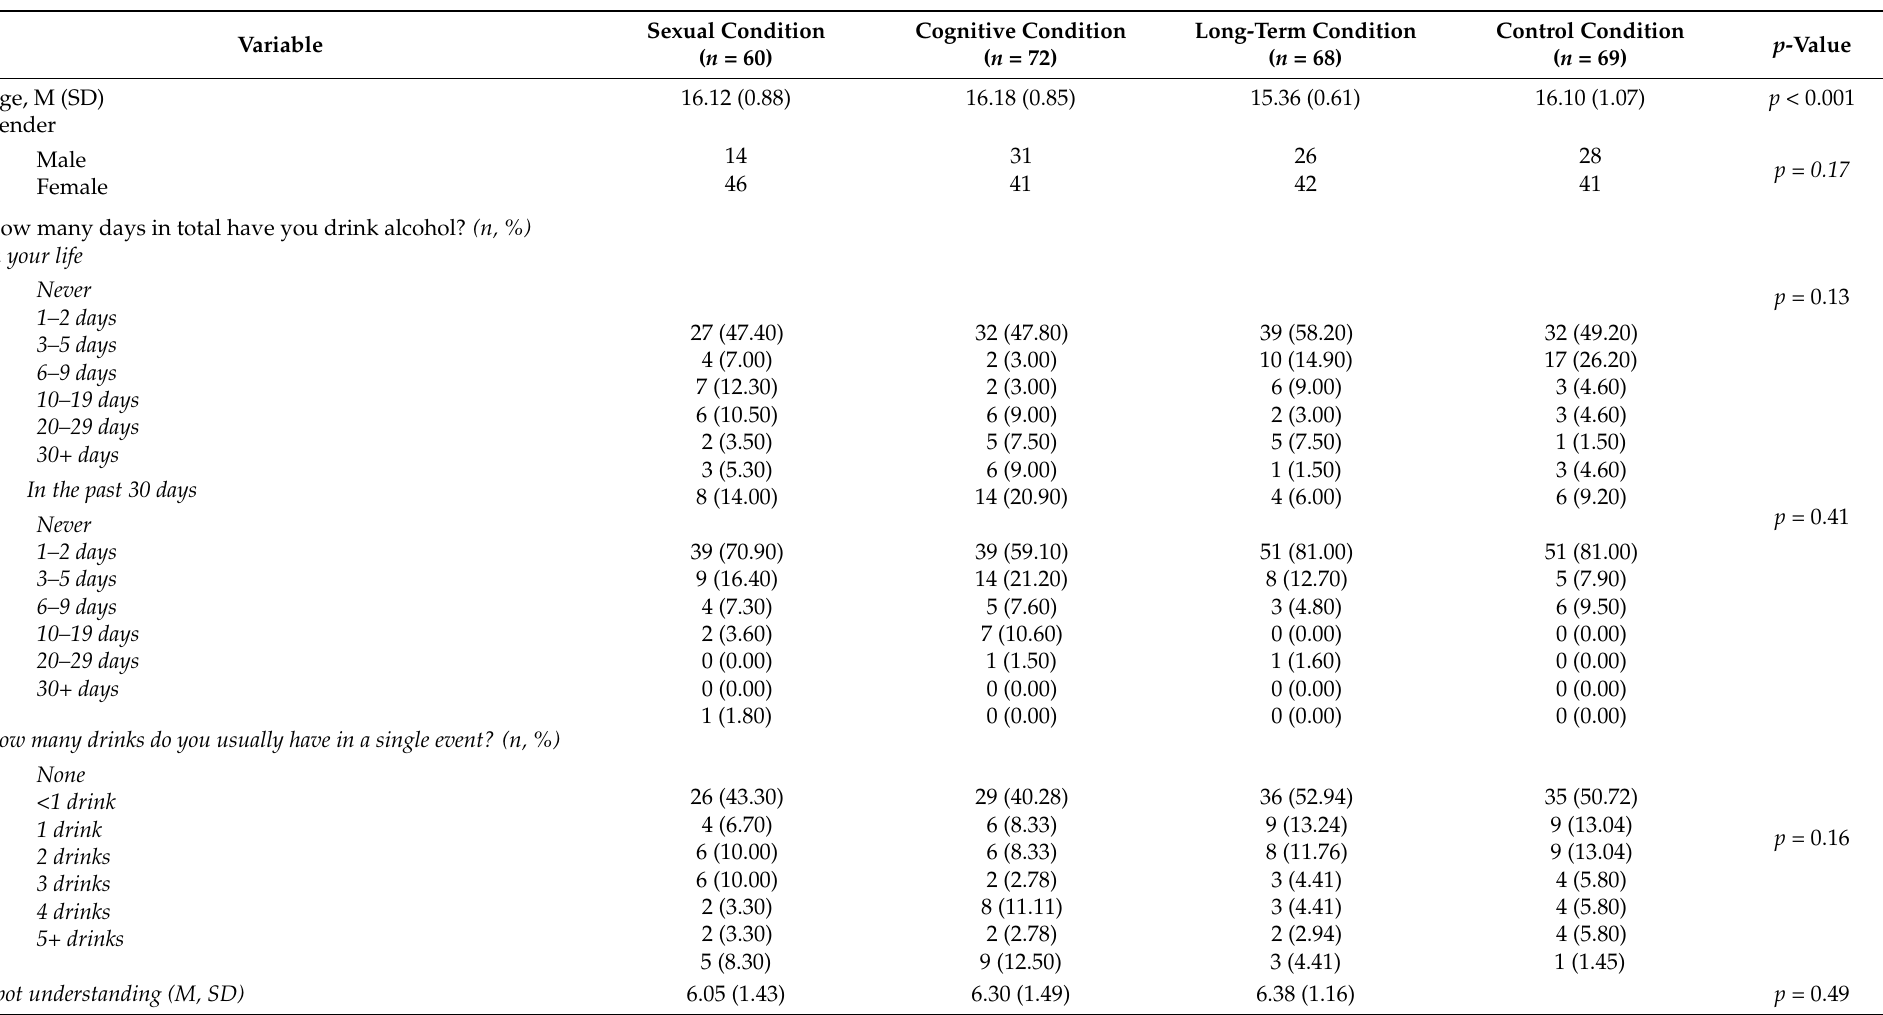
Table 1. Demographics characteristics, drinking frequency and intensity and spot understanding comparisons between the sexual, cognitive, long-term and control conditions.